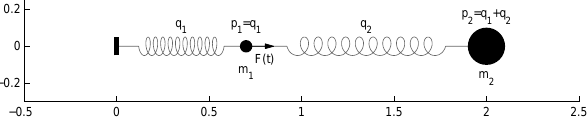
Figure 1. Example problem: two coupled oscillators with a fast oscillating small mass m 1 , see Burgermeister et al. (2011).